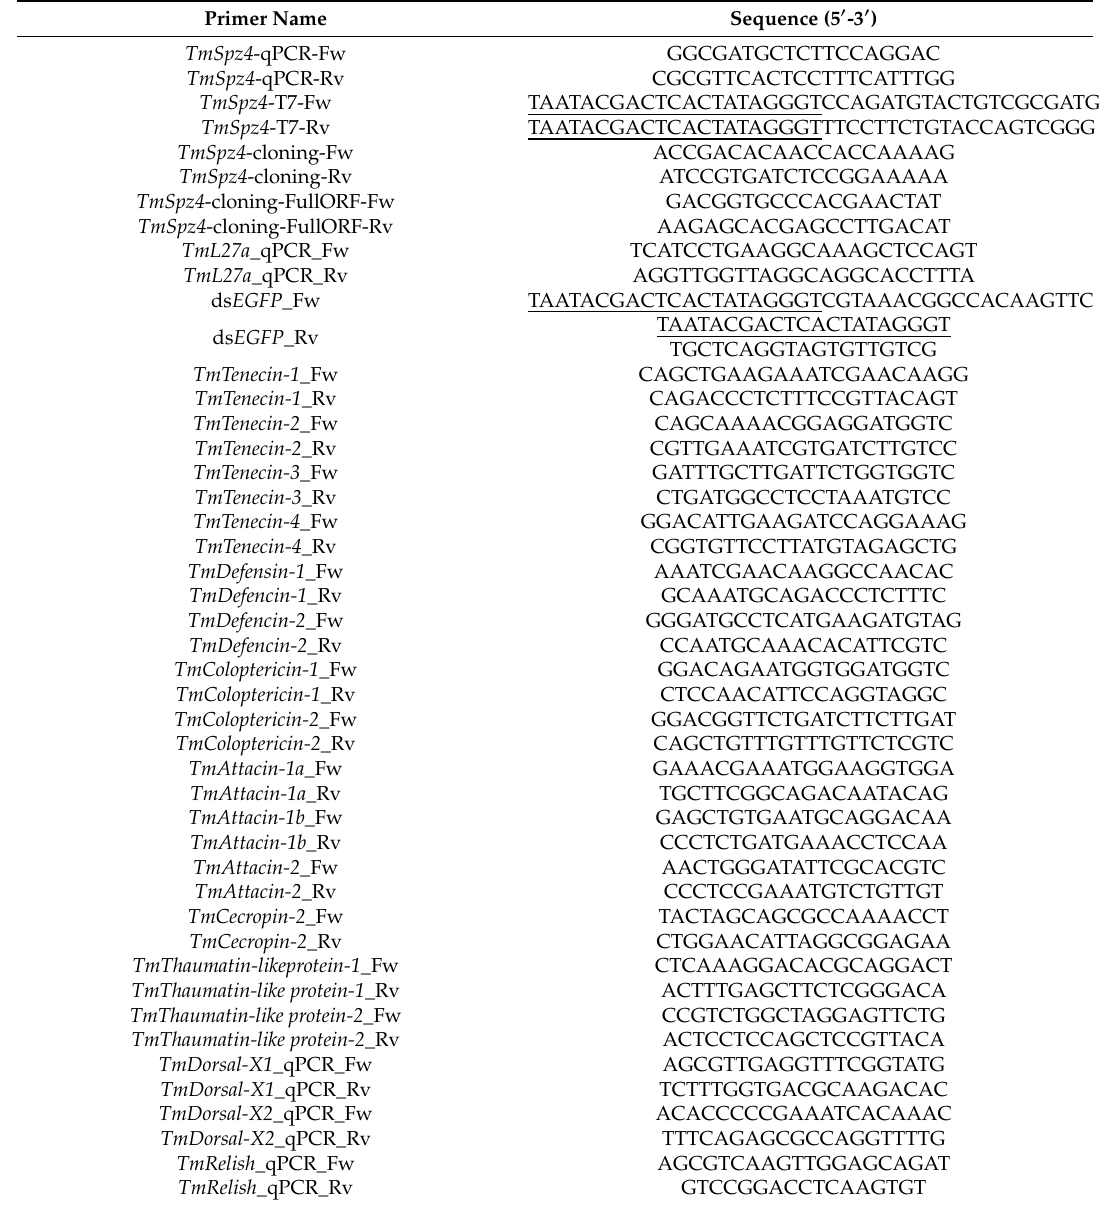
Table 1. Sequences of the primers used in this